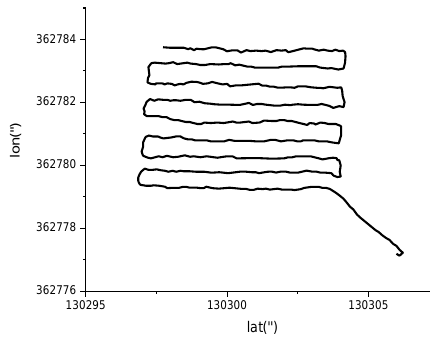
Figure 12. The results of area search test.